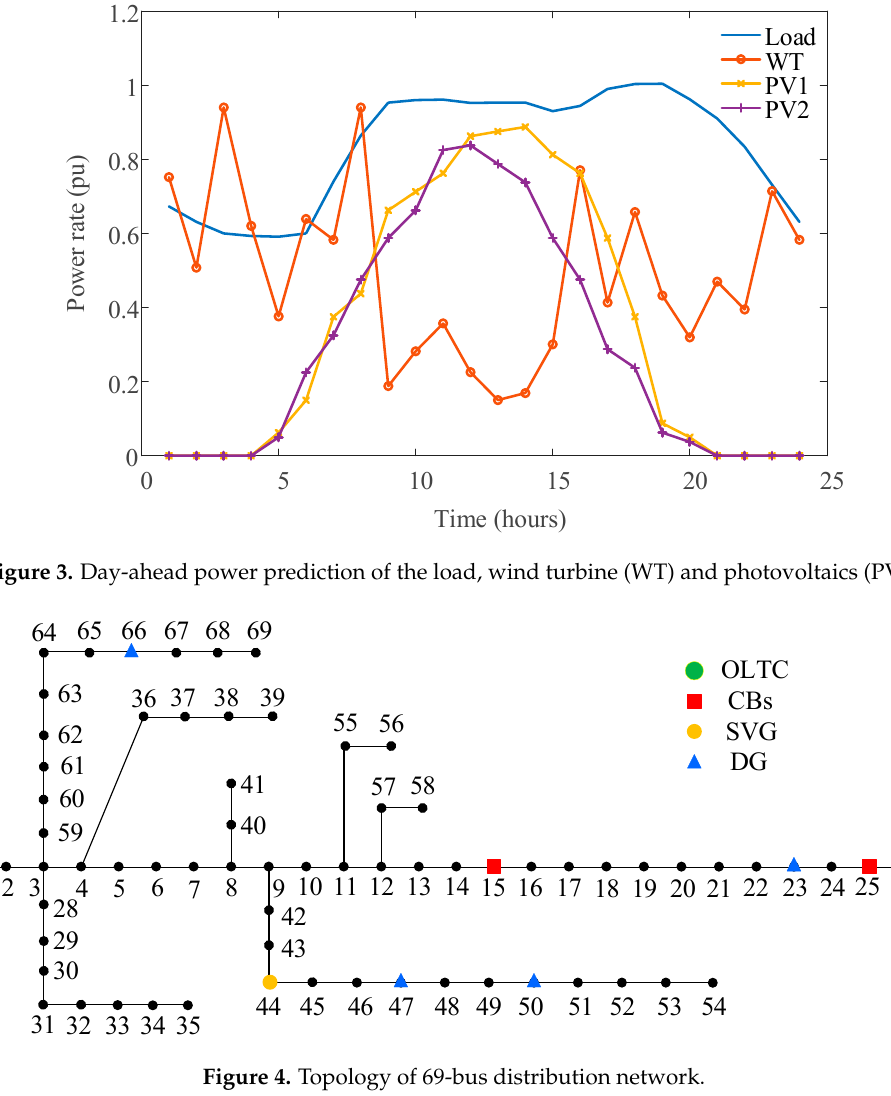
Figure 4. Topology of 69-bus distribution network. Table 3. Time-of-use electricity Table 2. Parameters of energy storage systems (ESSs).